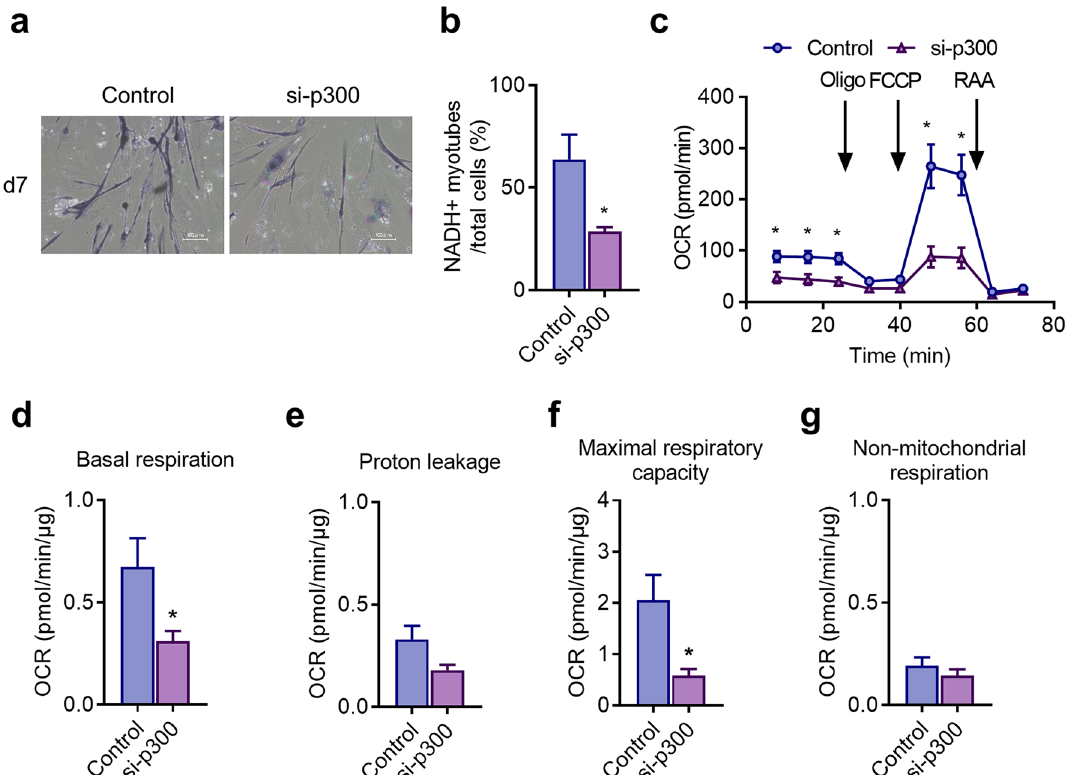
Figure 3. Metabolic effects of p300 knockdown on human-skeletal myogenesis in MyoD-hiPSCs. ( a ) NADH-TR staining detected myotube fibre types in MyoD-hiPSCs transfected with si-p300 or Control at day 7 after myogenic induction. Representative images are presented. Scale bars: 100 µm. ( b ) The graph shows the ratio of the number of stain-positive myotubes to total cell number counted in each microscopic field (n = 10). * p < 0.05 versus control. ( c ) MyoD-hiPSCs transfected with si-p300 or Control were evaluated using flux analyser at day 7 after myogenic induction. Levels of basal oxygen-consumption rate (OCR) were measured, and mitochondrial stress tests were performed using oligomycin (Oligo), FCCP, and rotenone-antimycin A. A representative example of five independent experiments is shown. ( d – g ) After the OCR measurements, cells were lysed, and protein concentration was measured to normalise OCR data obtained for basal respiration ( d ), proton leakage ( e ), maximal respiratory capacity ( f ), and non-mitochondrial respiration ( g ). n = 5. * p < 0.05 versus